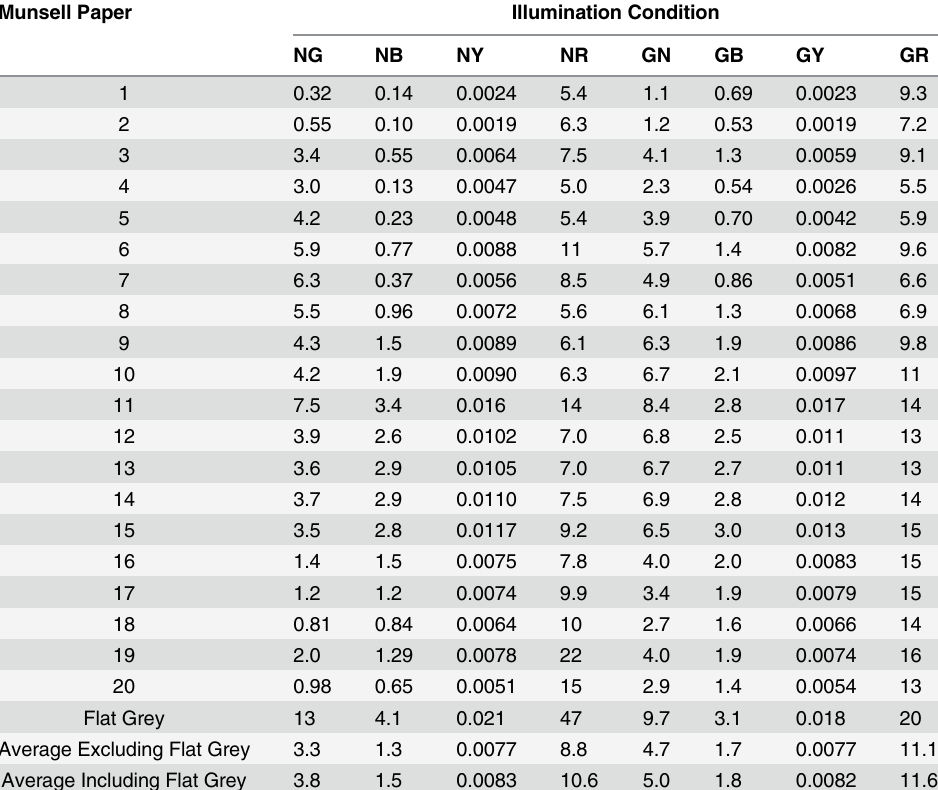
Table 1. Metamer-mismatch indices in percent. Rows correspond to papers that are numbered as in Fig 2 (left). Columns correspond to illumination conditions. Munsell